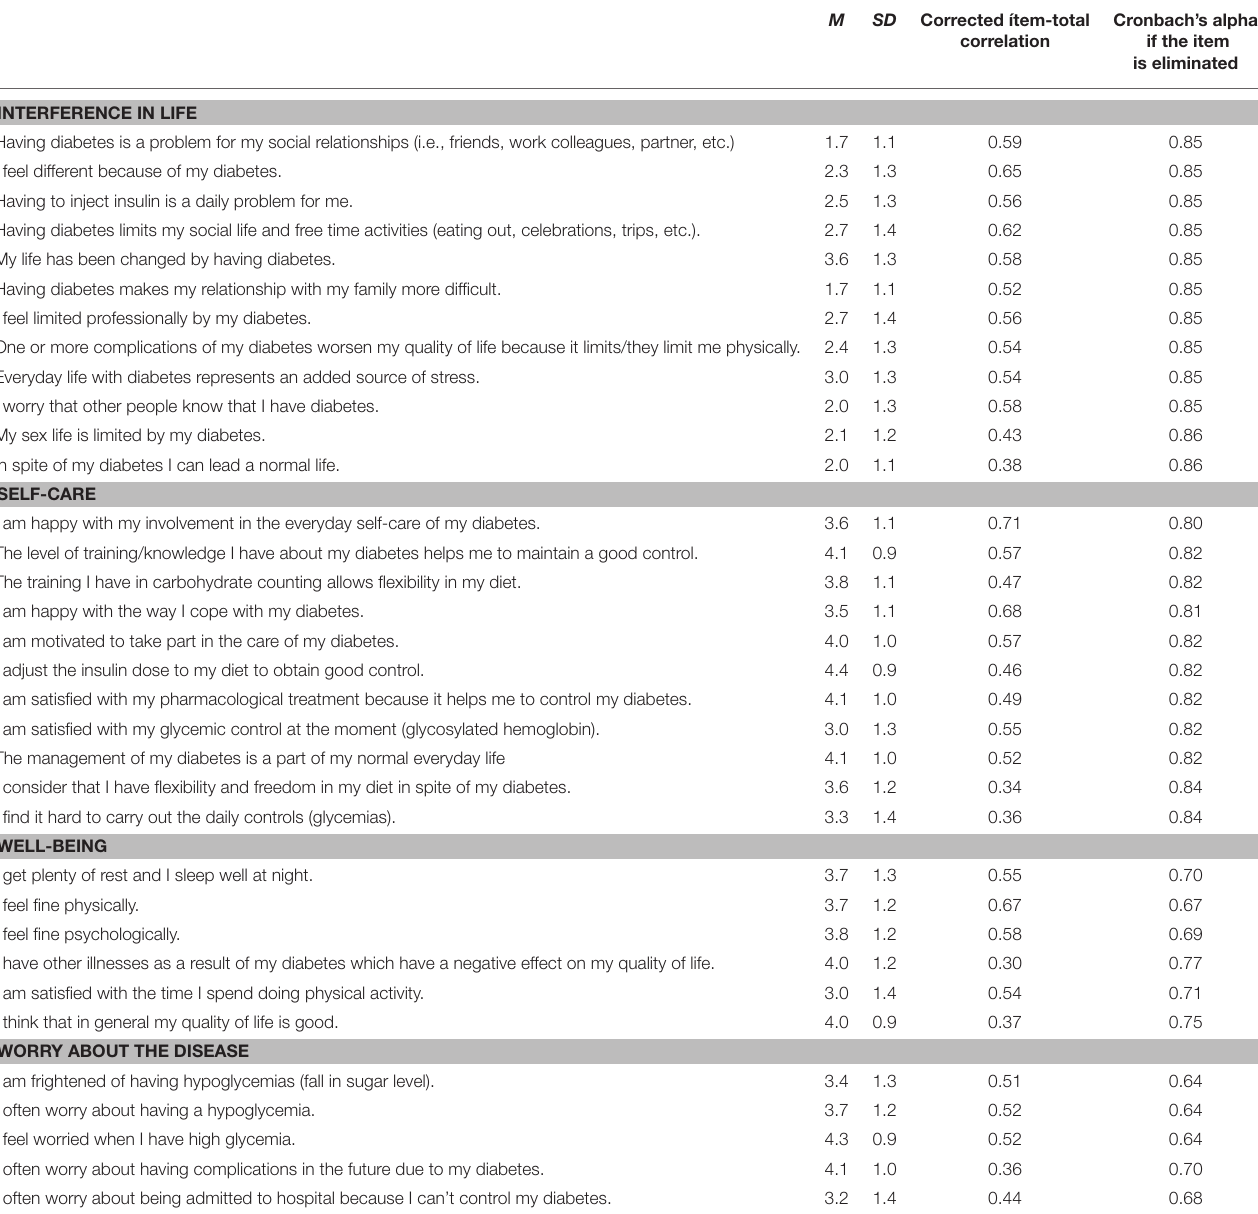
TABLE 4 | Descriptive analysis of the ViDa1 questionnaire. ( N = 578).